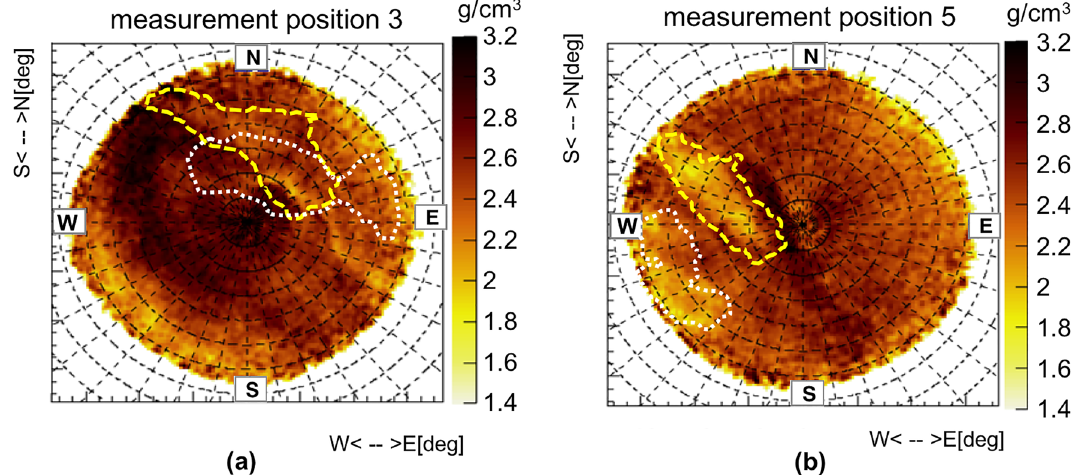
Figure 11. The mesh profile of unknown cavities reconstructed from measurement 1 superimposed on the density maps of the other measurements. In ( a ) and ( b ) the density angular distribution relating to the measurement positions 3 and 5 on which the profile of the reconstructed mesh is superimposed: the Gran Cava (dashed line), A and B (dotted line). The images are obtained with the ROOT